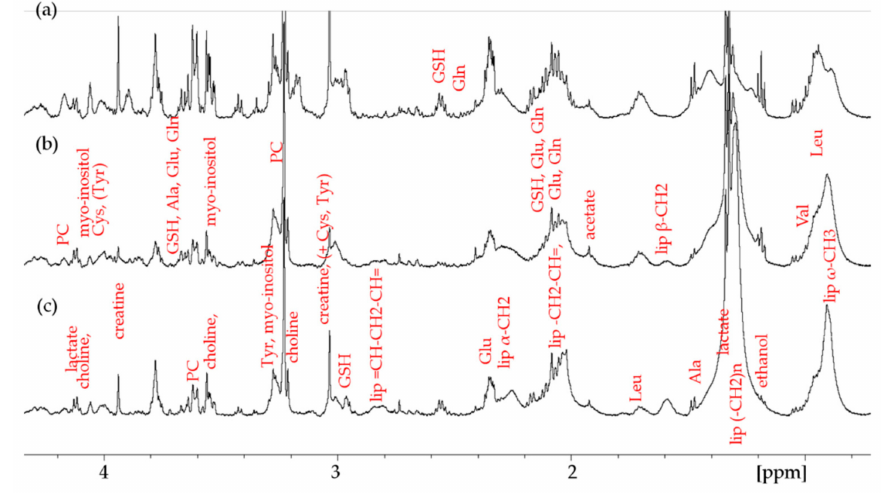
Figure 2. One-dimensional 1 H NMR NOESY spectra of untreated ( a ) HEK-293; ( b ) A2780; and ( c ) A2780cisR cells: Each spectrum represents an average of 10